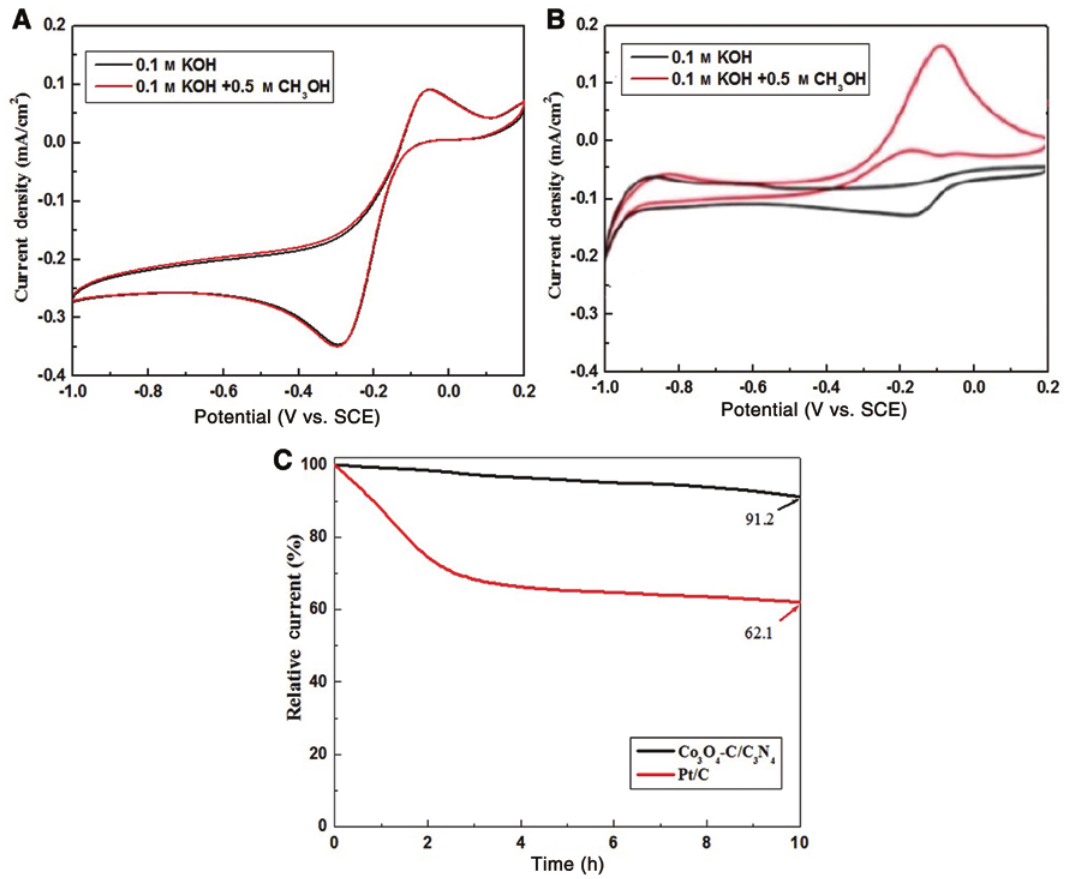
O -C/C N and Pt/C (20%) in O 3 4 3 4 O -C/C N and 20% Pt/C catalysts at -0.4 V (vs. SCE) in an O 3 4 3 4